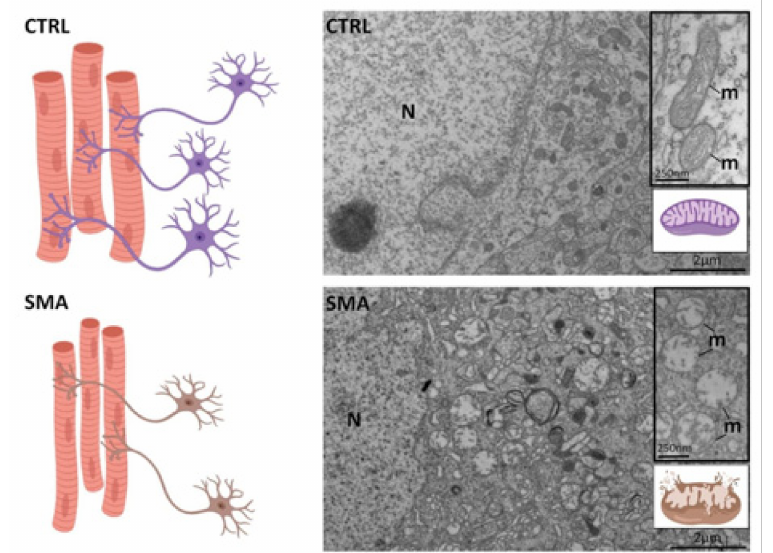
Figure 2. Peripheral dysfunctions in SMA. SMA is characterized by progressive MN death, im- paired innervation and muscular atrophy, contributing to NMJ destabilization. Among the known pathogenic mechanisms, mitochondrial alterations represent an early event. As shown in the Electron Microscopy images from spinal cord samples of the SMN ∆ 7 mice (postnatal day 10), compared to the control (CTRL), SMA mitochondria are clearly altered, dilated and fragmented. N = nucleus; m = mitochondria. Created with BioRender